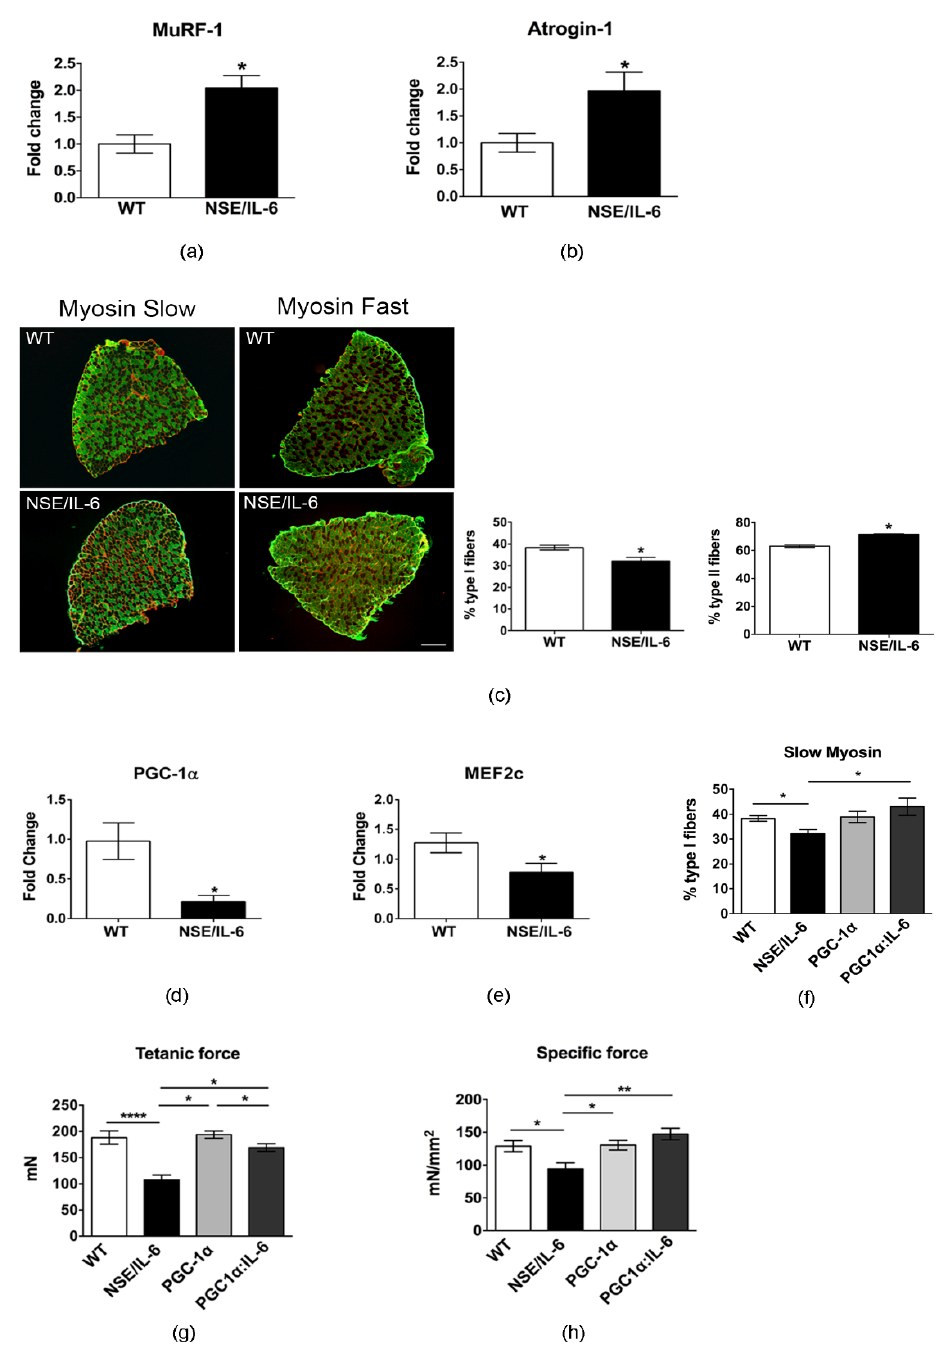
Figure 4. IL-6 overexpression impinges the heterogeneity of muscle fibers. ( a , b ) Real time PCR of ubiquitin-proteasome markers, Atrogin-1 and MuRF1 in soleus of wild type (WT) and NSE/IL-6 mice at 6 months of age. Values are expressed as fold change variations relative to WT and are presented as means ± SEM and n = 4; * p < 0.05. Statistical significance assessed by Mann–Whitney Rank Sum Test. ( c ) Immunofluorescence staining of wild type (WT) and NSE/IL-6 soleus muscles immunolabeled with either a mouse anti-myosin slow or a mouse anti-myosin fast antibody at 6 months of age. Scale bar 250 µ m. At the right, graphs showing the percentage of positive type I (left) or type II (right) muscle fibers. Data are represented as average ± SEM. n = 4 * p < 0.05. Statistical significance assessed by Mann–Whitney Rank Sum Test. ( d , e ) Real time PCR for the expression of PGC-1 α and MEF2c in soleus of wild type (WT) and NSE/IL-6 mice at 6 months of age. Values are presented as means ± SEM and n = 4; * p < 0.05. Statistical significance assessed by Mann–Whitney Rank Sum Test. ( f ) Quantification of immunofluorescence staining of wild type (WT), NSE/IL-6, PGC-1 α and IL-6:MCK/PGC-1